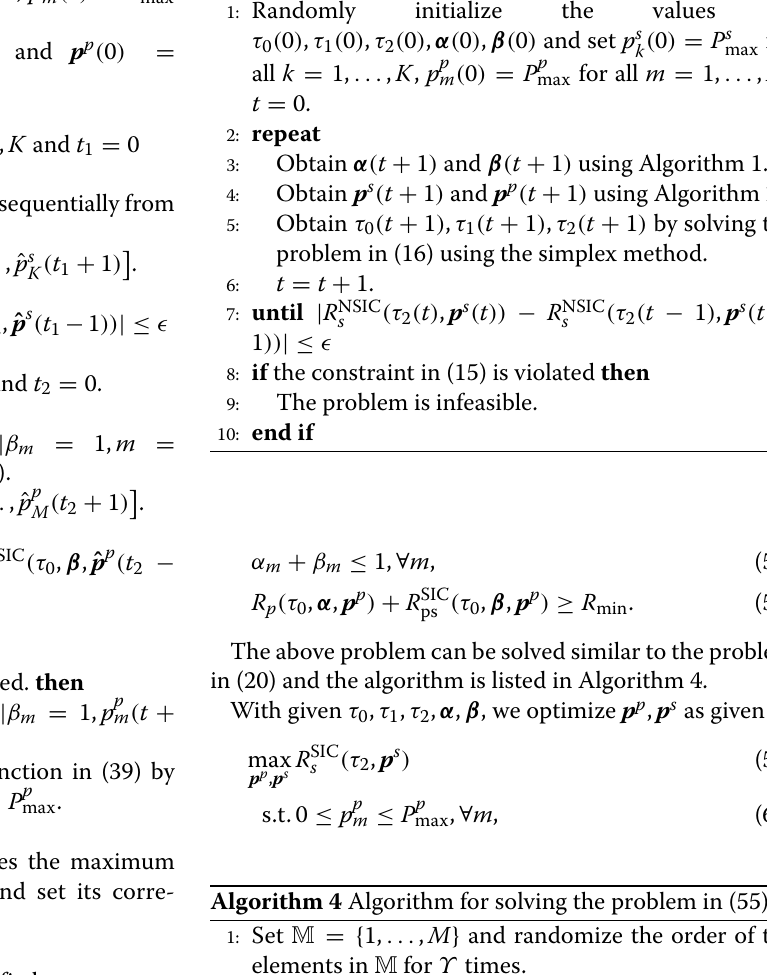
Algorithm 2 Algorithm for solving the problem in (27) Algorithm 3 Data traffic offloading scheme without SIC decoder at the SBS